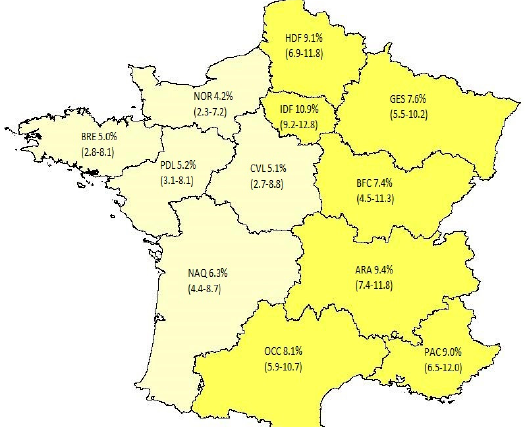
Figure 3. Prevalence of detected SARS-CoV-2 infection in the French working-age population (December 2020). Figure legend: Auvergne-Rhône-Alpes (ARA), Bourgogne-Franche-Comté (BFC), Bretagne (BRE), Cen-tre-Val de Loire (CVL), Grand Est (GES), Hauts-de-France (HDF), Ile-de-France (IDF), Normandie (NOR), Nouvelle-Aquitaine (NAQ), Occitanie (OCC), Pays-de-la-Loire (PDL), and Provences-Alpes-Côte-d’Azur (PAC).